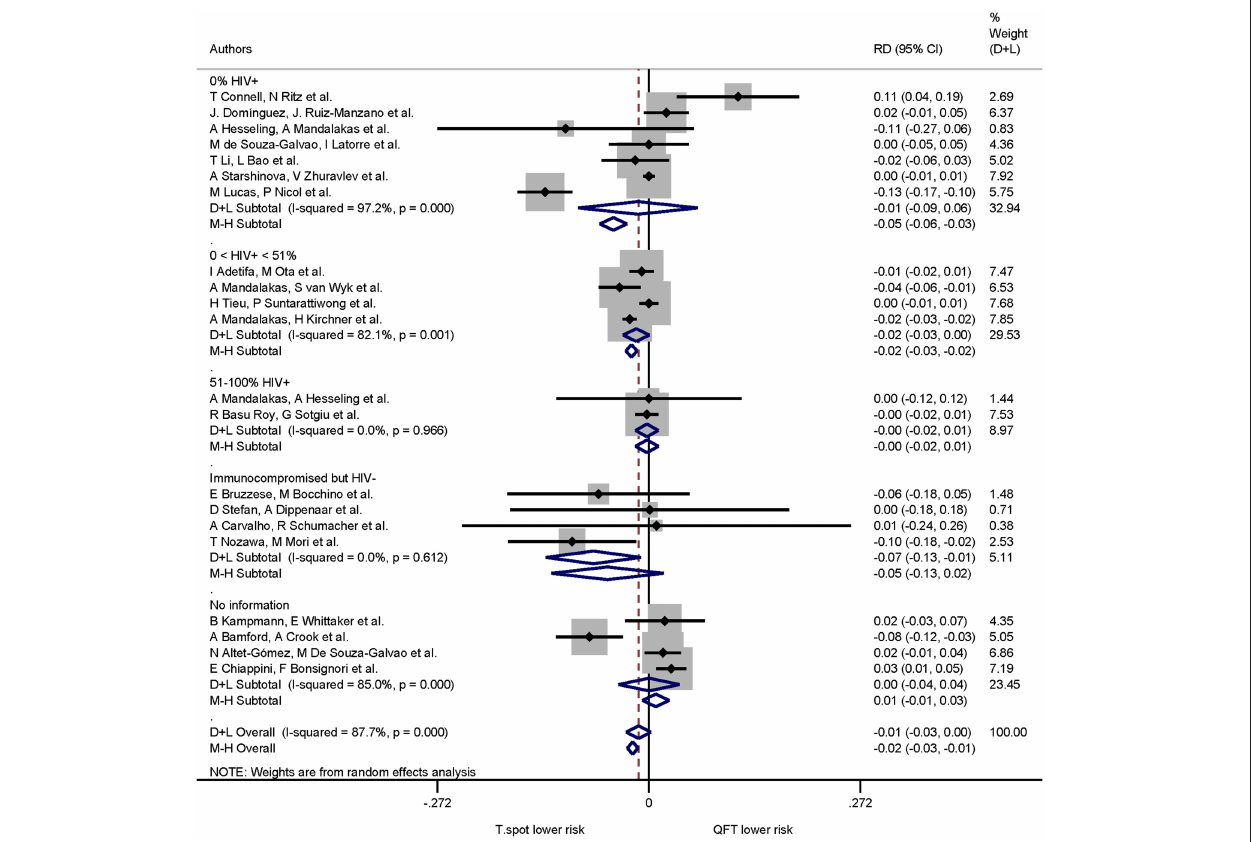
FIGURE 7 | Risk differences (RD) with 95% CI in studies that included a head-to-head comparison of QuantiFERON-TB and T-SPOT.TB assays stratified by immune status. Studies arranged according to year of